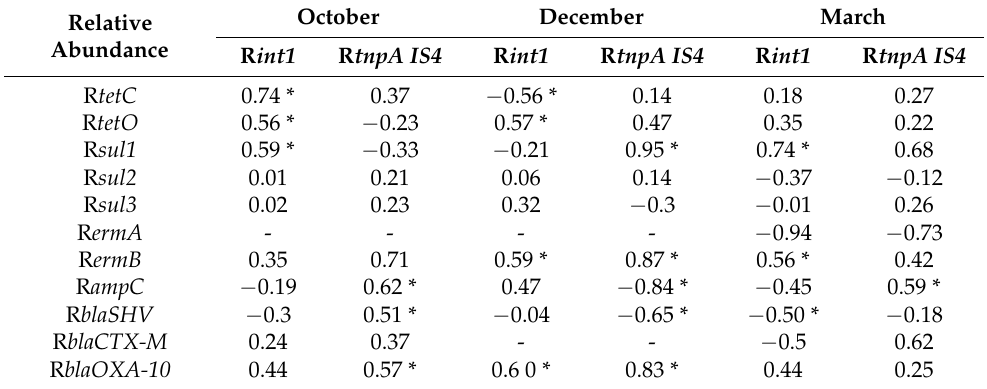
Table 2. The value of Pearson correlation between ARGs and int1 and tnpA IS4 at different times.